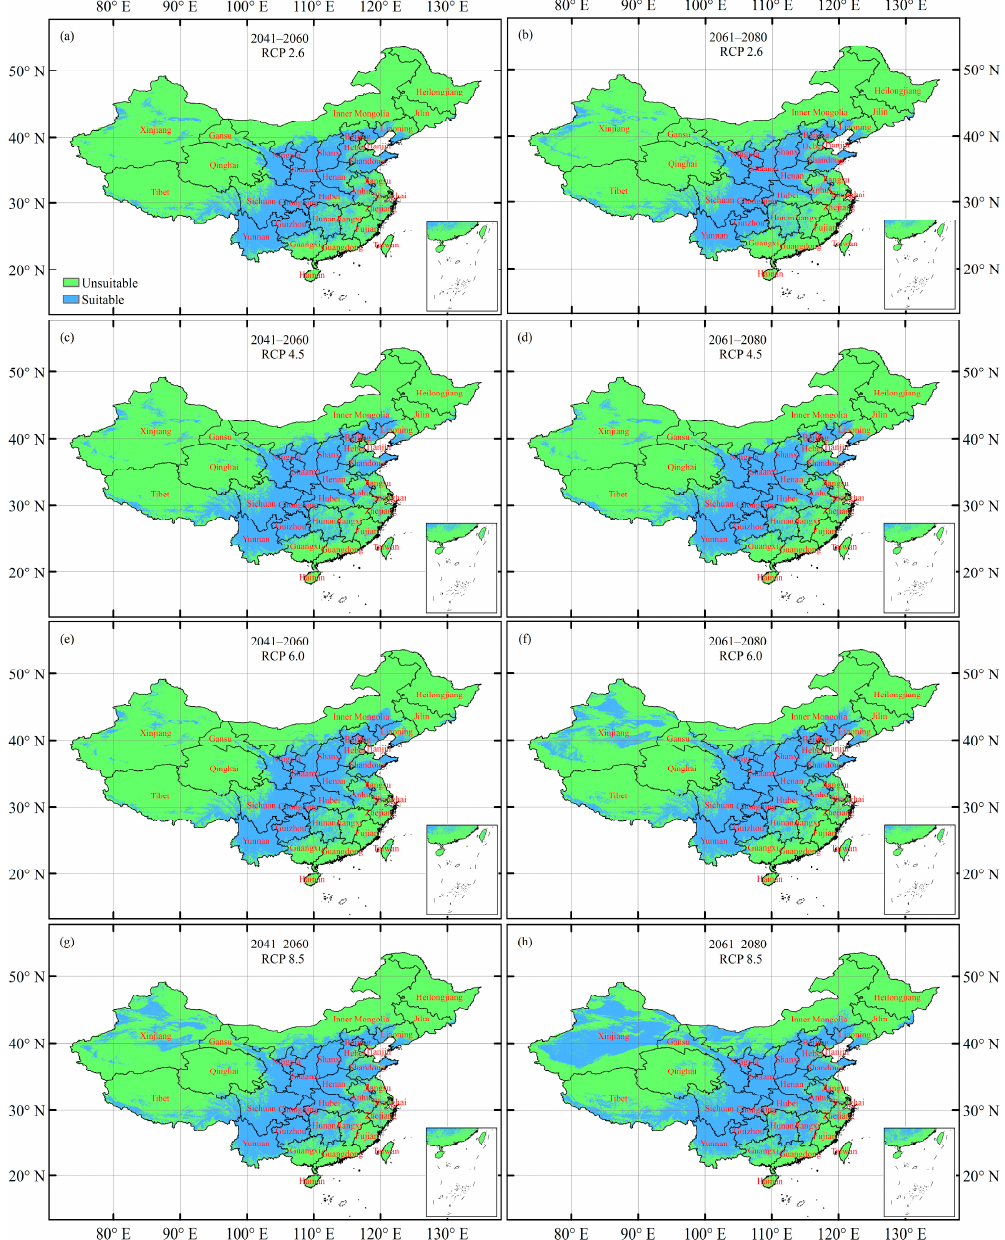
Figure 4. Potentially suitable climatic distribution of Juglans regia under different climate change scenarios in China. ( a ) Period of 2041–2060 in the representative concentration pathway (RCP) 2.6 climate scenario; ( b ) period of 2061–2080 in the RCP 2.6 climate scenario; ( c ) period of 2041–2060 in